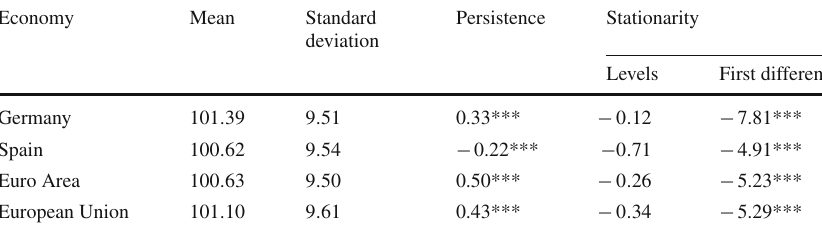
Table 2 Descriptive statistics. Source: author’s calculations